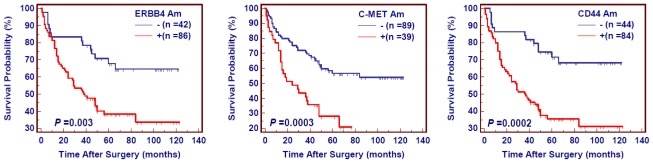
The effect of amplification of ERBB4, C-MET and CD44 on poor survival in gastric cancer. Kaplan-Meier survival curves were made according to the presence of gene amplification in a cohort of gastric cancers. The patients with gene amplification had significantly shorter survival times than the patients without gene amplification. Am, amplification; +, harboring gene amplification; −, the lack of gene amplification.